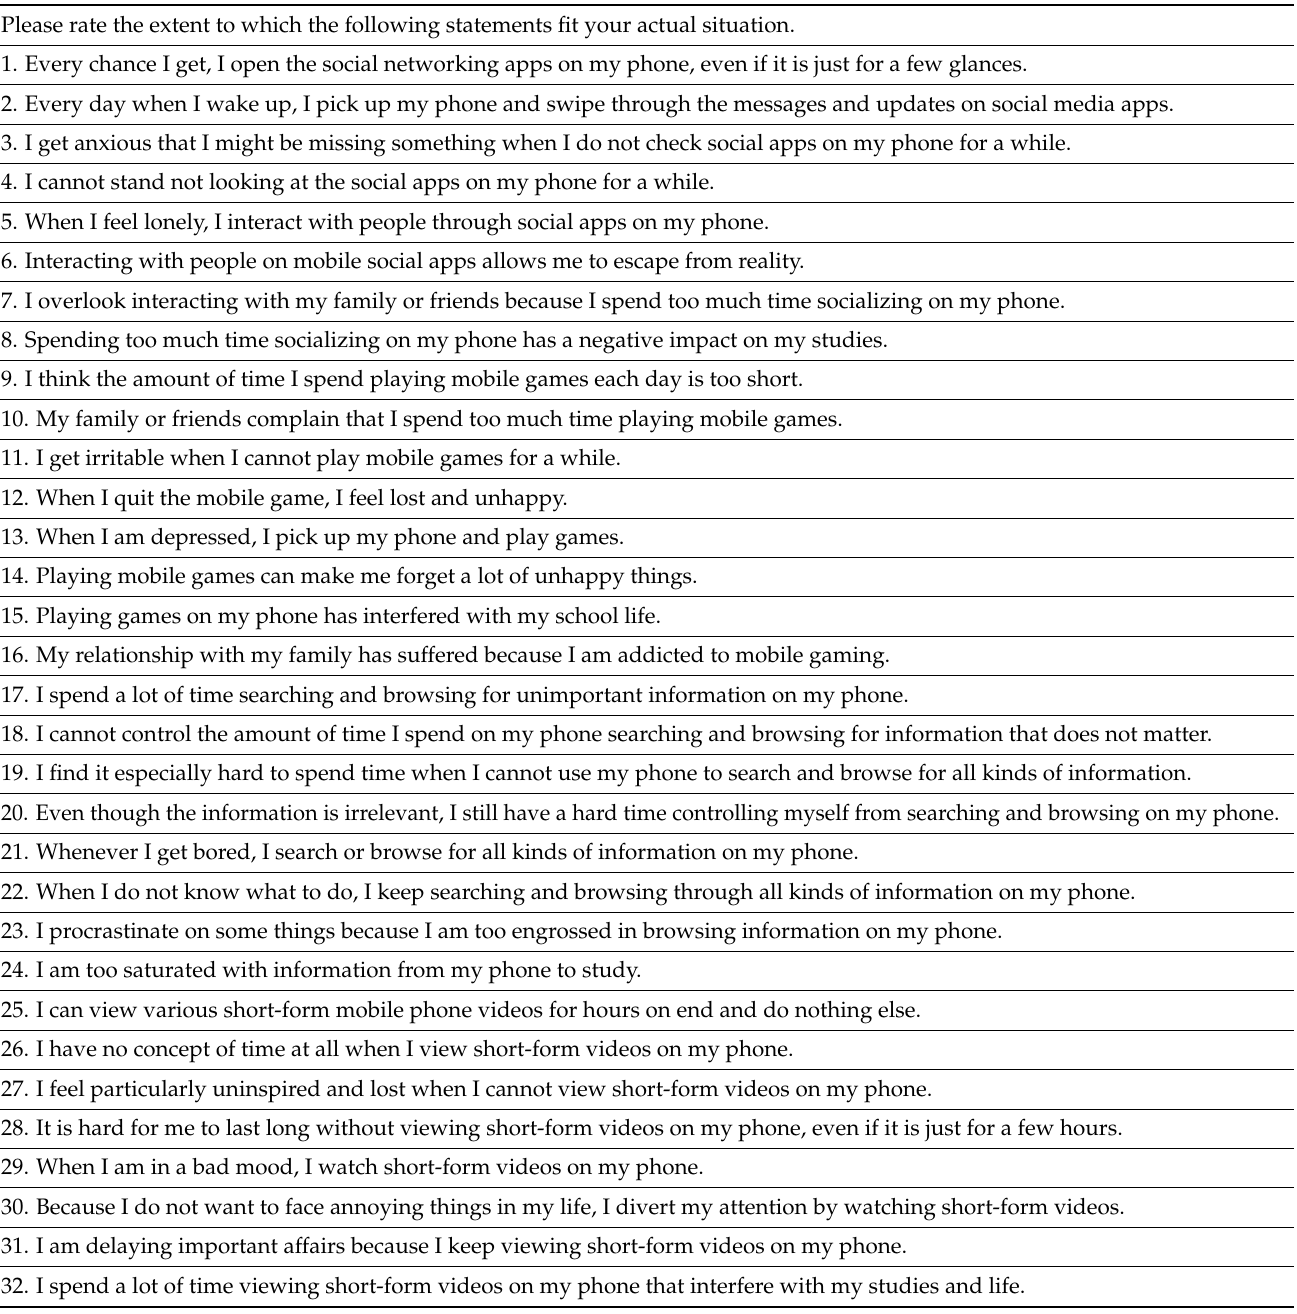
Table A2. Initial version of the Mobile Phone Addiction Type